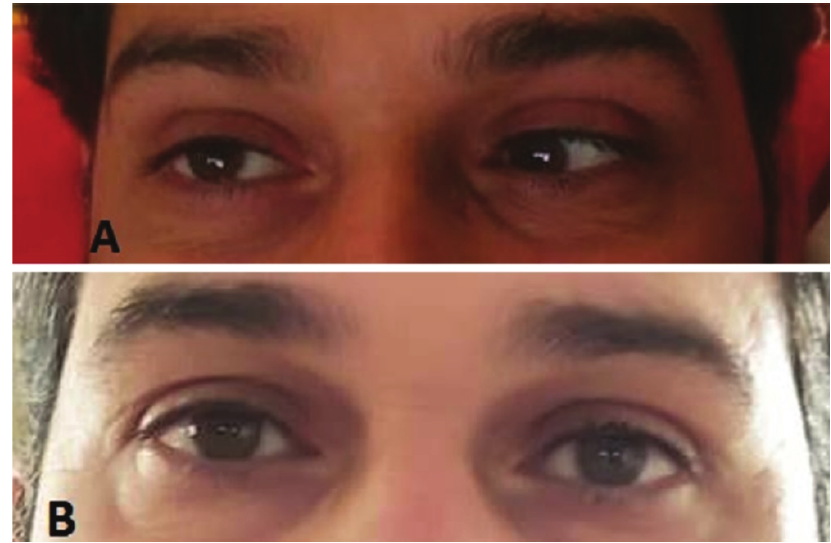
Figure 1. External eye photos in primary gaze position, at presentation (A) showed left eye esotropia, and three month later (B) showed no deviation.